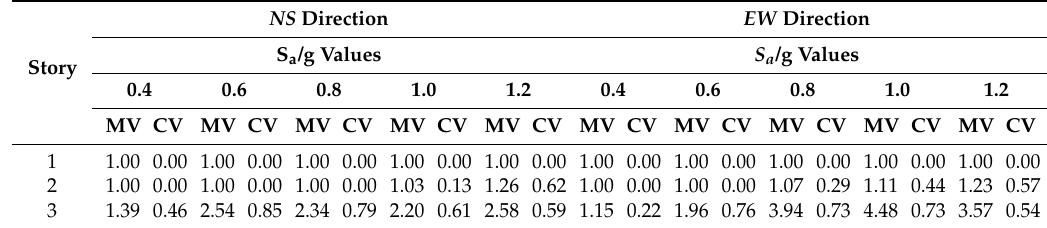
Table 5. Statistics for µ L δ for columns of the 3-level building